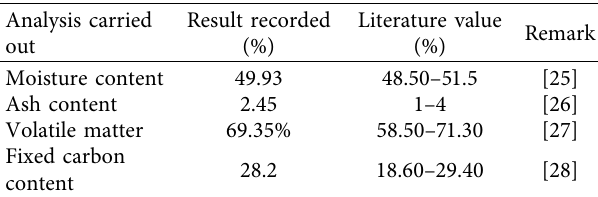
Table 2: Literature value obtained one for proximate analysis of raw